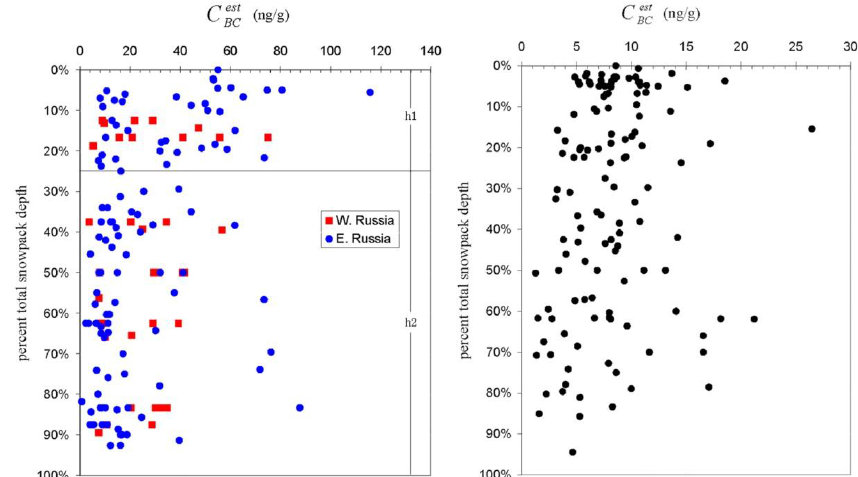
Fig.1. Vertical profile of sBC concentrations in the Arctic snow from the field measurements in west (2007) and east (2008) Russia (left), and profiles from the field measurements in Canada in spring 2009 (right). C est BC denotes the estimated true mass of BC per mass of snow. These two figures are respectively from Fig. 12a and Fig. 9 (left panel) in Doherty et al. (2010), but with some necessary modifications to highlight different concentrations of sBC in various depths. The snowpack depths in Russia and Canada were respectively 34±7 cm and 30±14 cm across all measurement sites.